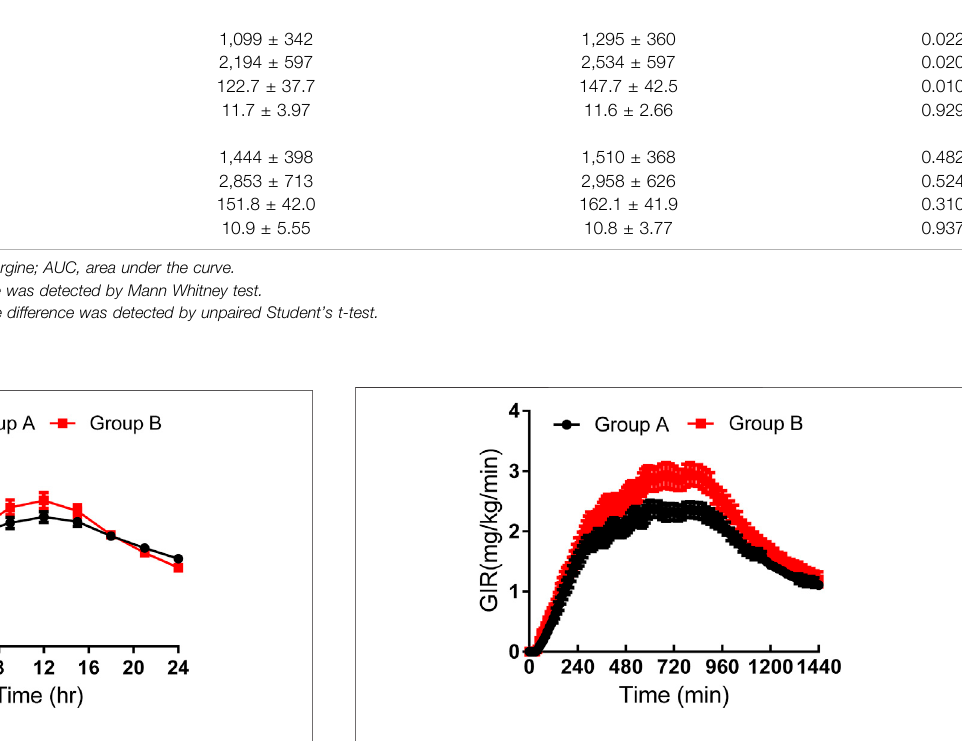
FIGURE 4 | Time-pro fi les of glucose infusion rate throughout the euglycemic clamp in groups A and B, respectively (Mean ±